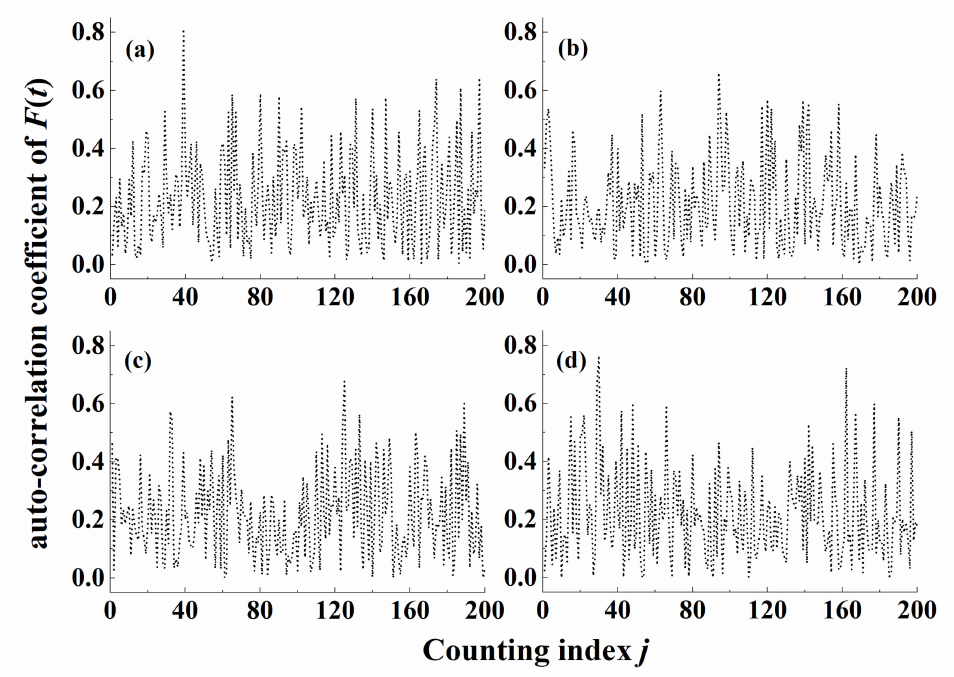
( t ) and F U ( t ) under typical cases of θ . allow allow